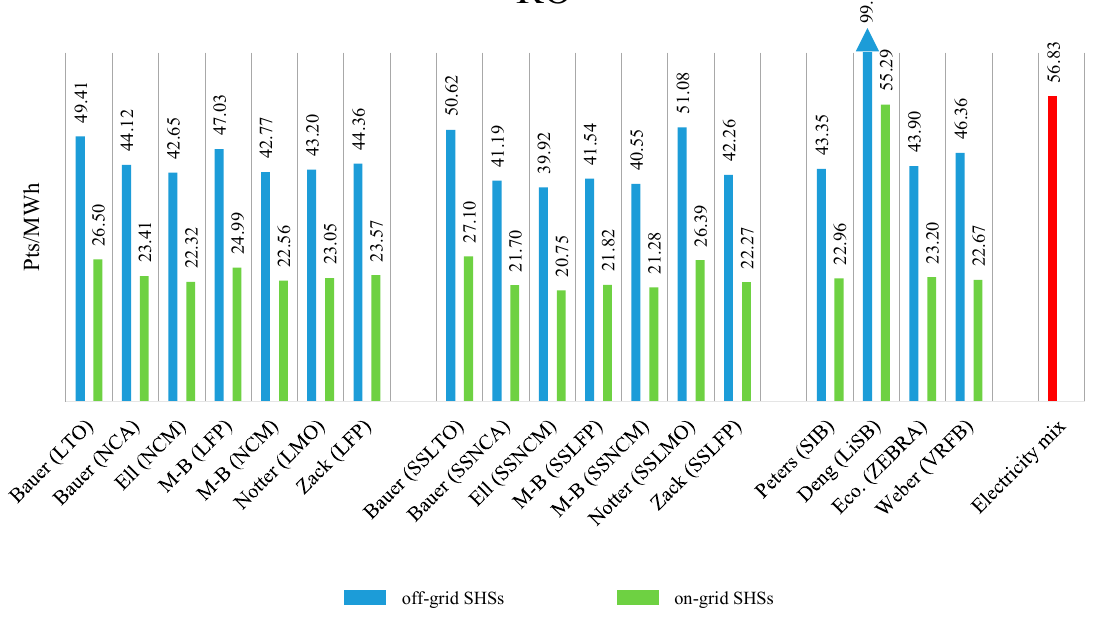
Figure 12. LCA impact values of SHSs in Romania as single scores.